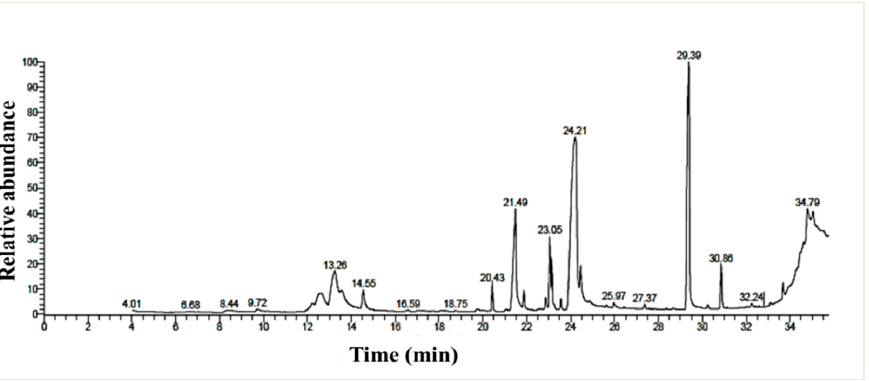
Figure 3. GC/MS chromatogram of the P. chrysogenum MZ945518 non-polar ethyl acetate extract.